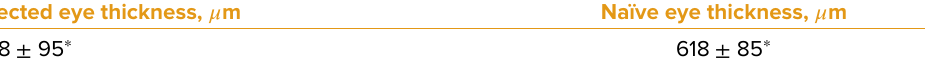
Table 2. Scleral thickness measurements summary in the injected quadrant Injected eye thickness, 𝜇